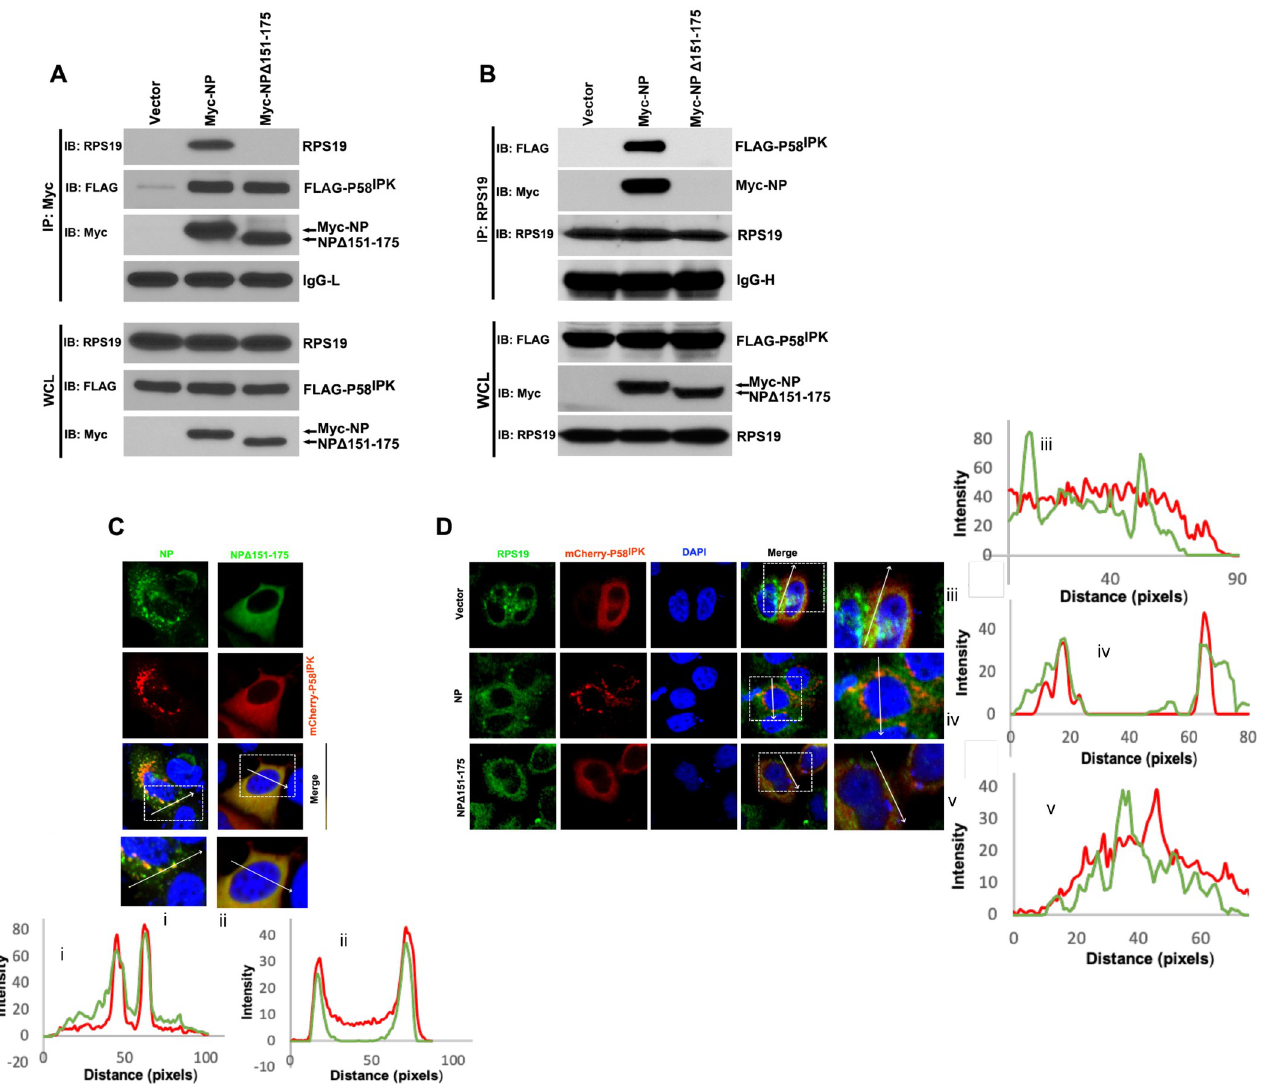
Fig 5. NP recruits P58 IPK to the 40S ribosomal subunit. A. HEK293T cells were cotransfected with plasmids expressing FLAG-P58 IPK along with either Myc- NP or Myc-NP Δ 151–175 deletion mutant. Cell lysates were immunoprecipitated with anti-Myc antibody. The whole cell lysate (WCL) or immunoprecipitated material was examined by western blot analysis (IB) using either anti-RPS19 or anti-FLAG tag or anti-Myc tag antibodies. B. HEK293T cells were transfected as mentioned in panel A. The cell lysates were immunoprecipitated with RPS19 antibody. The whole cell lysate (WCL) or immunoprecipitated material was examined by western blot analysis (IB) using either anti-RPS19 or anti-FLAG tag or anti-Myc tag antibodies. C. HeLa cells were cotransfected with plasmids expressing mCherry-P58 IPK along with either Myc-NP or Myc-NP Δ 151–175 deletion mutant. The cells were examined by confocal microscope. The wild type NP and NP Δ 151–175 mutant were visualized using anti-Myc primary antibody and a secondary antibody conjugated with Alexa Fluor 488. Quantification of the boxed zoomed area in the merged panels was carried out using imageJ as described in Fig 3D and presented as line graph at the bottom. The red and green fluorescence signals show strong colocalization evidenced by the significant increase in both fluorescence signals at the same location above the background. D. HeLa cells were cotransfected with mCherry-P58 IPK expressing plasmid along with either empty vector or plasmids expressing wild type NP or NP Δ 151–175 deletion mutant. The cells were examined by confocal microscope. The RPS19 was visualized using a primary anti-RPS19 antibody and a secondary antibody conjugated with Alexa Fluor 488. Quantification of the boxed zoomed area in the merged panels was carried out using imageJ as described in Fig 3D and presented sidewise as line graph. Unlike panels iii and v, the red and green fluorescence signals in panel iv show colocalization evidenced by the increase in both fluorescence signals at the same location above the